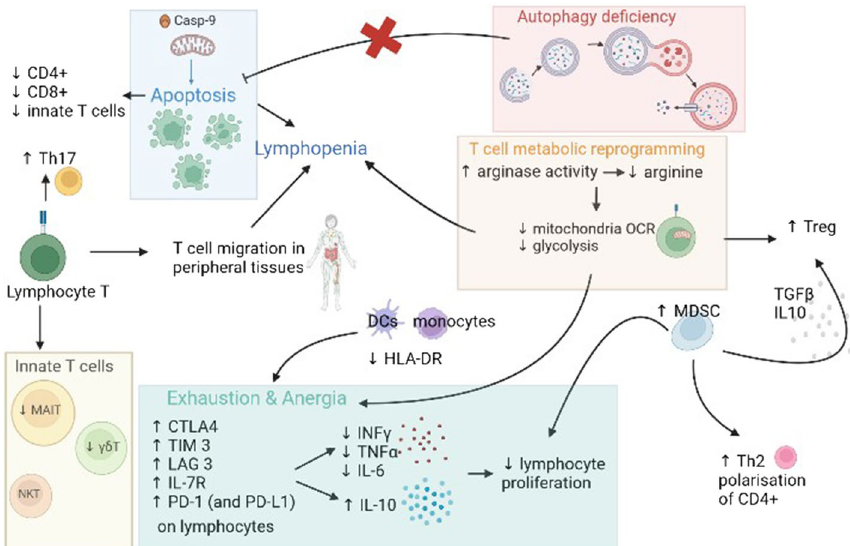
Fig. 1 T cells dysregulation in critical illnesses. T cell alterations include lymphopenia with polarization of Th cells towards Th2, increase of Th17 cells, increase of Tregs and reduction of innate T cells (MAIT cells and γδT cells). The main mechanisms responsible for these alterations are: lymphocyte apoptosis, autophagy deficiency, lymphocyte metabolic reprogramming and T cell anergy and exhaustion. Lymphocyte apoptosis: